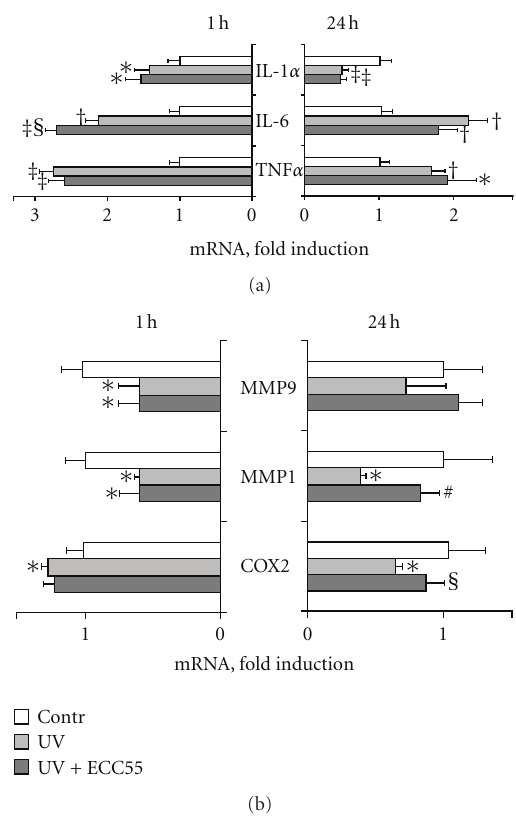
Figure 2: E ff ects of concentrated ethanol extract of Edelweiss callus cultures (ECC55) on UV-induced gene expression in cultured human keratinocytes. (a) Expression of inflammatory cytokine genes at 1h and 24h after irradiation with or without preincu- bation with ECC55 (25 μ g/mL). (b) Expression of matrix met- alloproteinases 9 and 1 genes (MMP9 and MMP1) as well as cyclooxygenase-2 gene (COX-2) at 1 h and 24h after irradiation. Error bars in all figures correspond to S.D. ∗ P < 0.05; † P < 0.01; ‡ P < 0.001 versus control cells; § P < 0.05; # P < 0.01 versus UV-irradiated